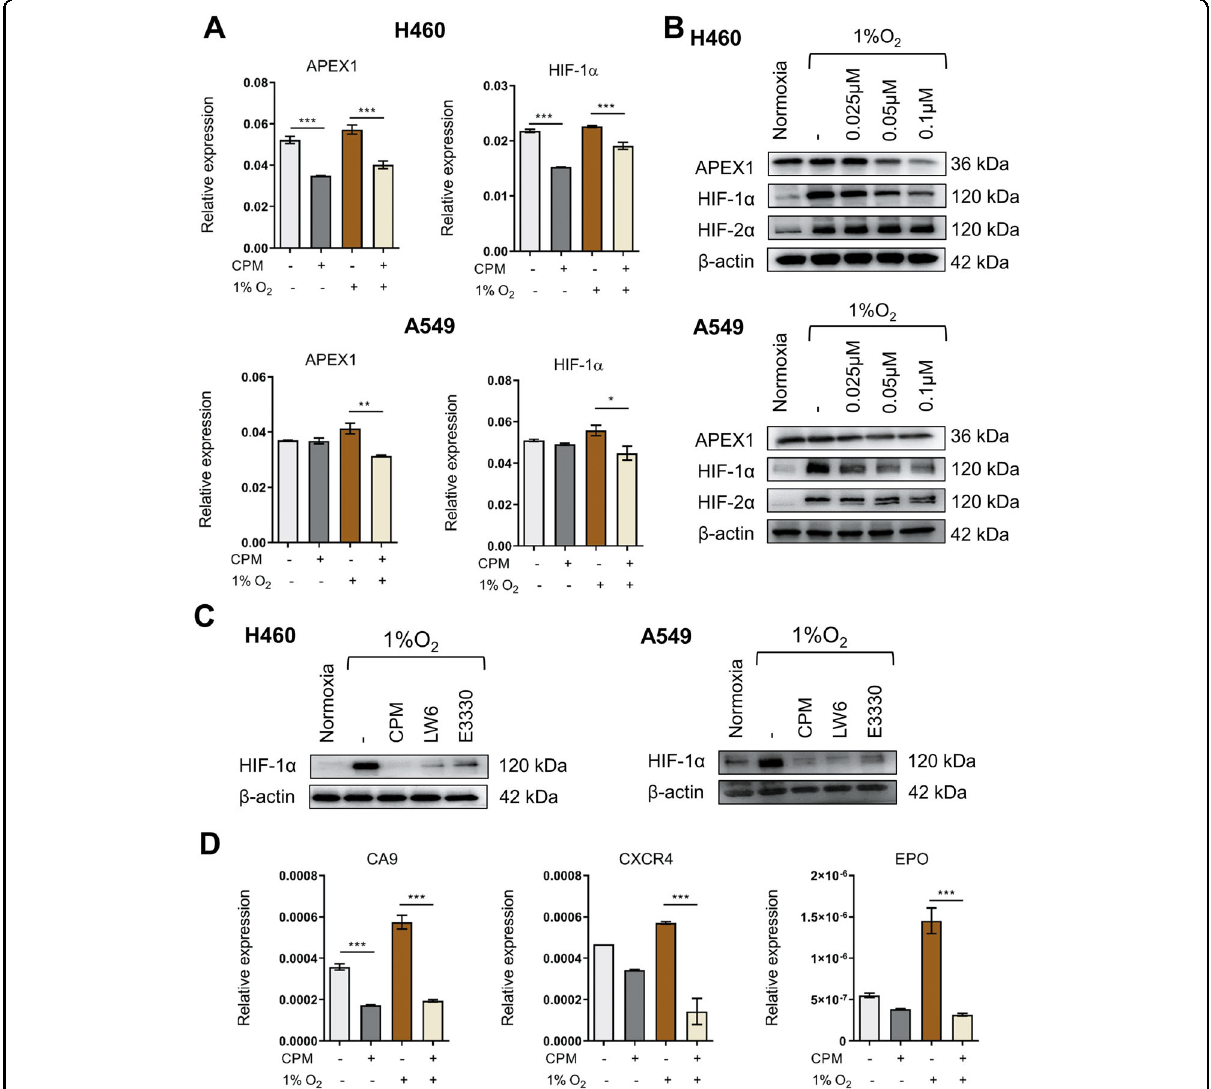
Fig. 2 CPM inhibited APEX1/HIF-1 α expression in hypoxic LC cells in vitro. A RT-qPCR analysis of APEX1 and HIF-1 α expression in H460 and A549 cells with or without CPM during hypoxia and normoxia. B H460 and A549 cells were treated with CPM and cultured under 1% O 2 . HIF-1 α and APEX1 protein levels were determined by western blotting. β -Actin was used as a control. C H460 cells were treated with CPM, 10 μ M APEX1 inhibitor E3330, and 5 μ M LW6 in normoxia and hypoxia. Protein expression of HIF-1 α was assessed by western blotting. D Relative expression of CA9, CXCR4, and EPO in H460 cells treated with CPM in normoxia and hypoxia. Data were expressed as mean ± SEM ( n = 3). * P < 0.05, ** P < 0.01, *** P < 0.001 compared as